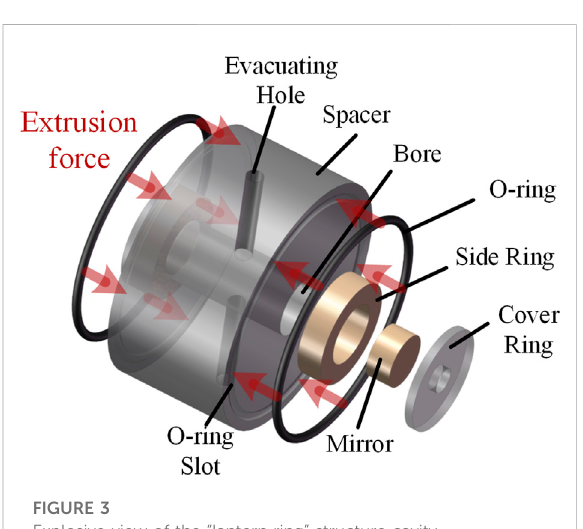
Explosive view of the “ lantern ring ” structure